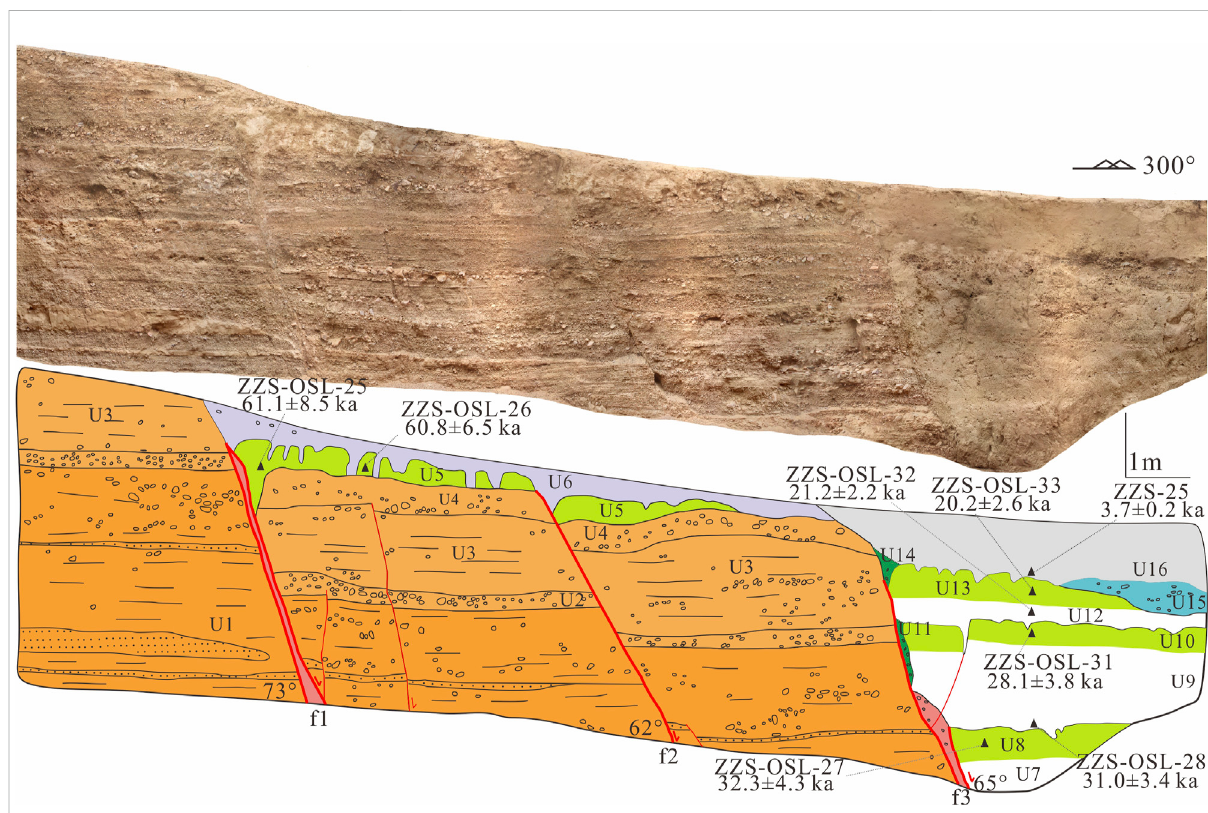
Photomosaic and corresponding sketch map of trench 2. The sample numbers and results are shown in the trench log. The thick red line indicates the main fault, and the thin line mainly indicates some secondary faults. Strata of the same color represent similar sedimentary units; for example, the grass green represents different buried paleosols and the dark green represents fi lling